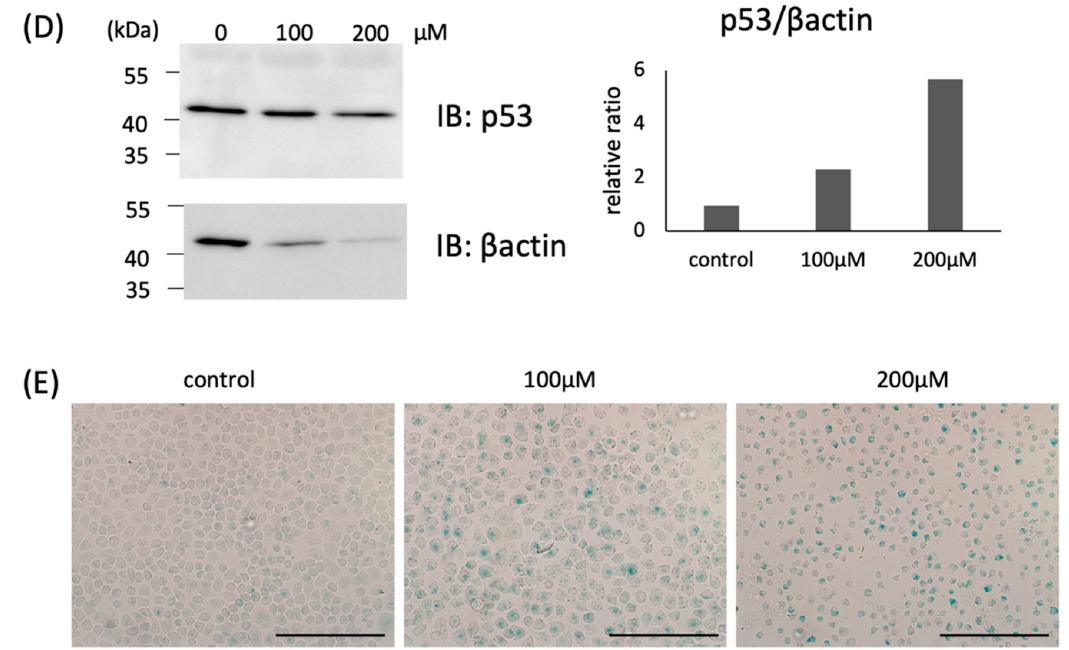
Figure 2. Increased expression of Ccn3 mRNA and protein in H 2 O 2 -treated chondrocytes. ( A ) Human primary articular chondrocytes isolated from 48 years old patient and ( B ) RCS cells were treated with increased concentration of H 2 O 2 as indicated for 2 h to induce artificial senescence by oxidative stress, followed by changing to the normal growing media without H 2 O 2 . Total RNA was collected 24 h after changing media, and ( A ) CCN3, p21, p53, COL2A1, ACAN, COL10A1, MMP13 mRNA, and ( B ) Ccn3 , p21 , p53 , Col2a1 , Acan , Col10a1 , Mmp13 , and Adamts5 mRNA levels were monitored and standardized with Gapdh . The data represent the mean ± SD ( n = 3 individual cultures); * p ≤ 0.05. ( C ) Cell lysates were collected both 24 and 48 h after changing media and CCN3 protein level was monitored with an anti-CCN3 antibody. ( D , left) Cell lysates were collected 48 h after changing media and p53 protein level was monitored with an anti-p53 antibody. ( D , right) Band intensity of p53 was standardized to β actin. ( E ) Colorimetric detection of senescence associated β galactosidase in H 2 O 2 -treated RCS cells. RCS cells were treated with H 2 O 2 at indicated concentration for 2 h and after media change further incubated for 36 h. bar: 200 µm.